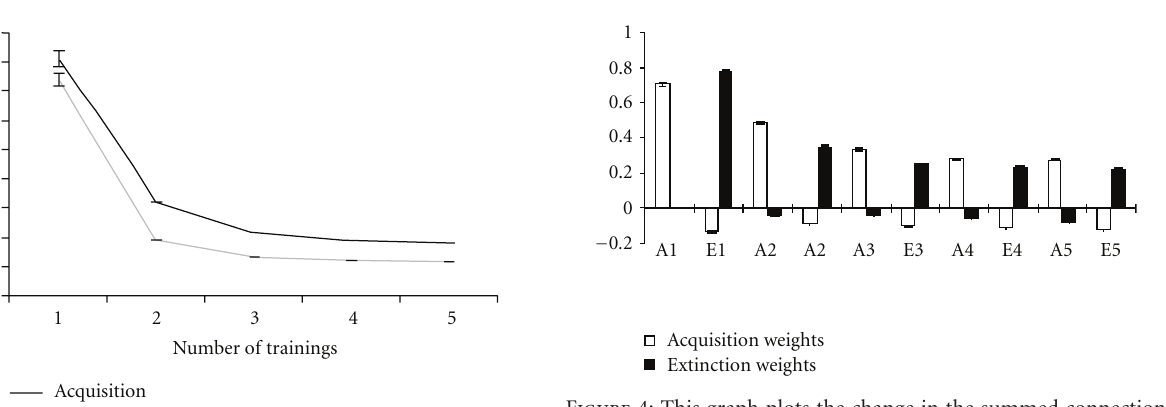
Figure 4: This graph plots the change in the summed connection weights in the acquisition pathway and in the extinction pathway ( y - axis) during the successive acquisition and extinction trainings ( x -axis). The change in weights decreases in both the pathways as the number of prior acquisitions and extinctions training sessions increases. There seems to be a slow upward going trend in the weights in both the pathways, which appears to be a quirk of the simulator.